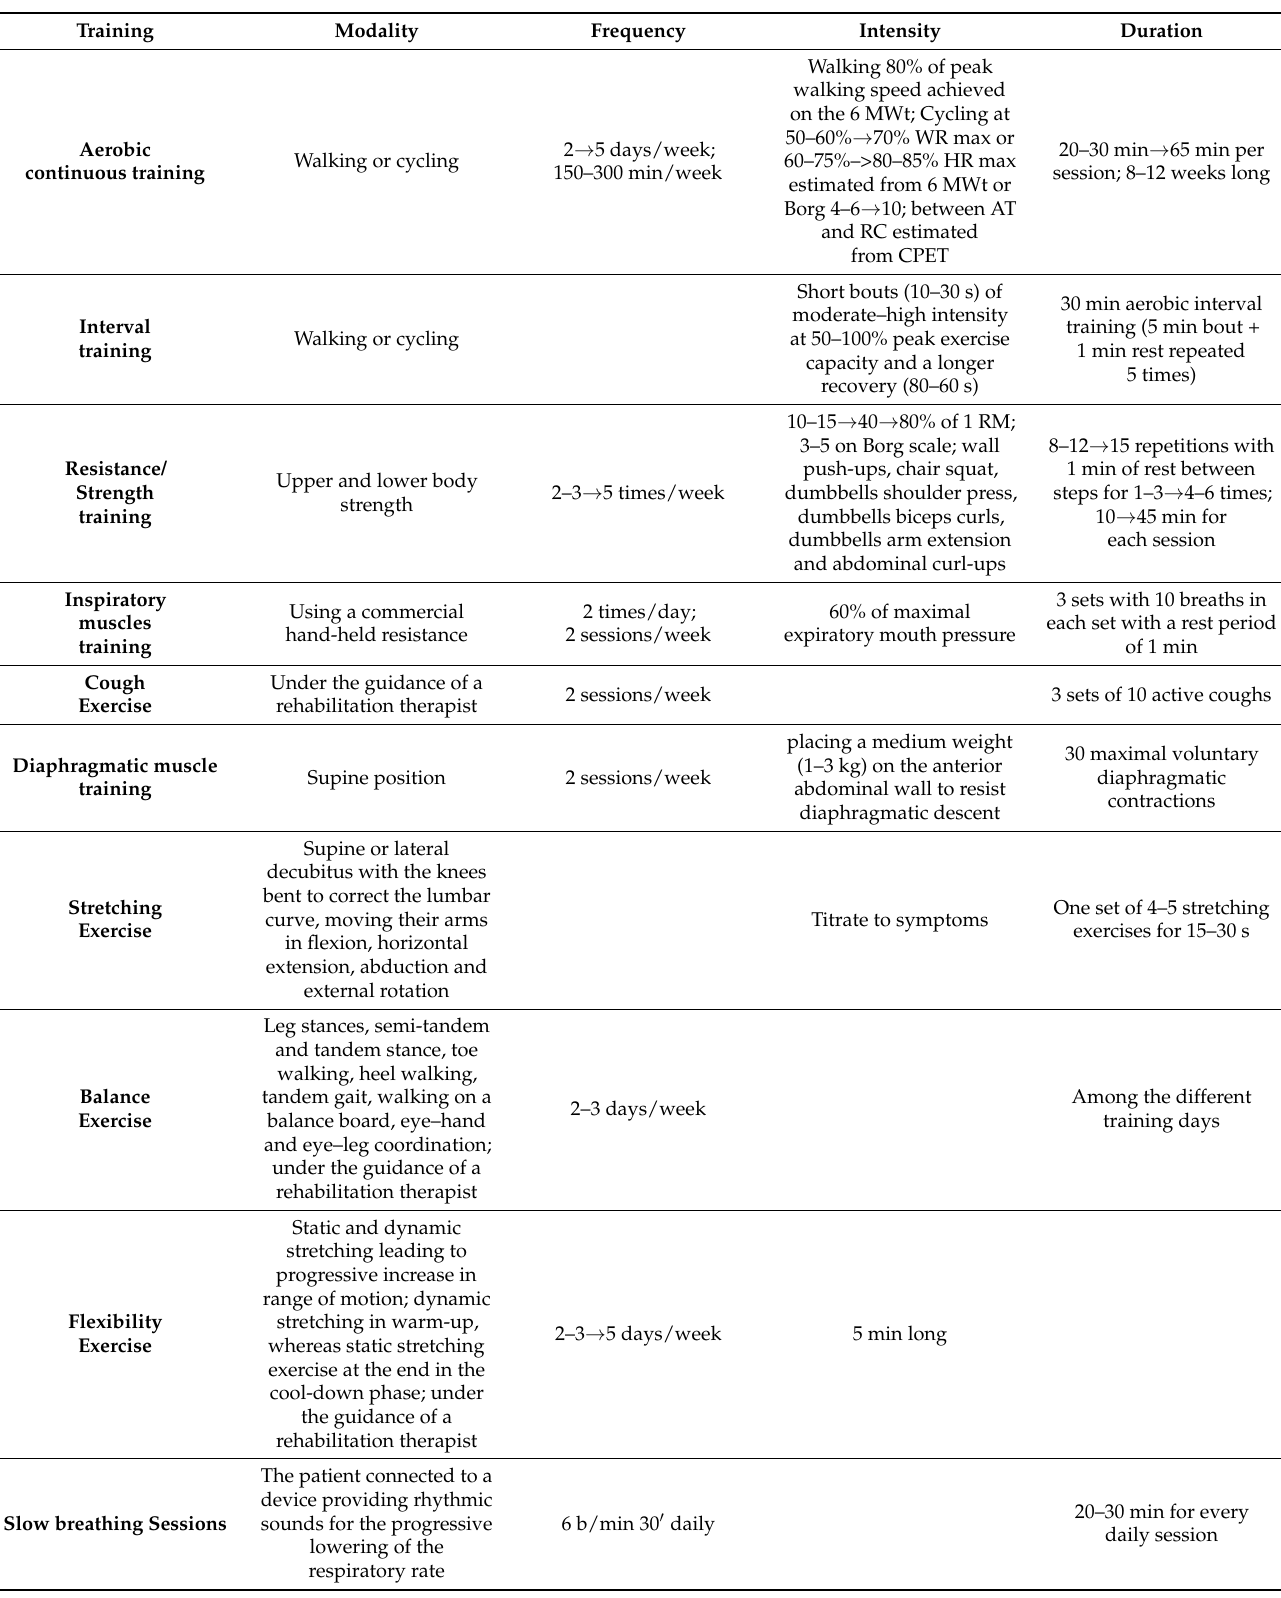
Table 5. The new combined post-COVID-19 exercise